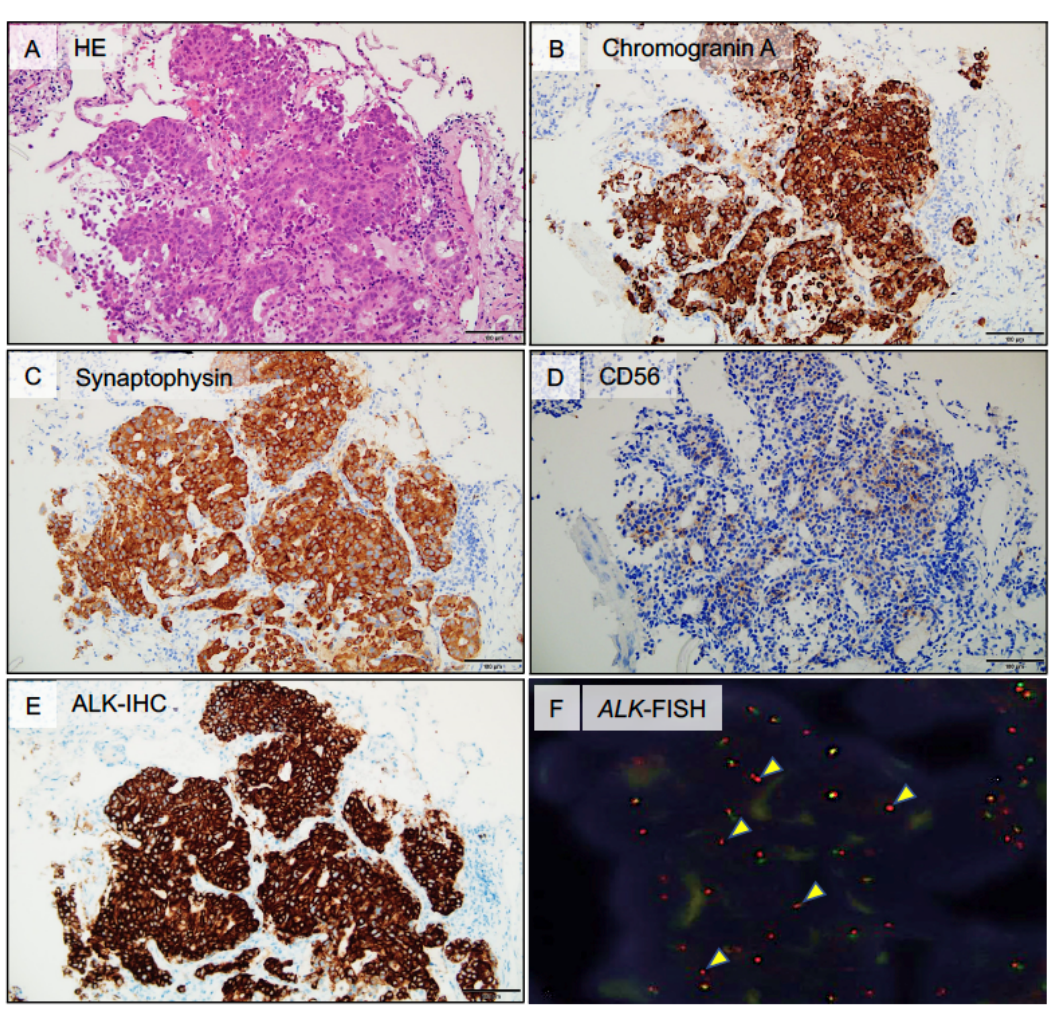
Figure 2. Histopathological findings of the mediastinal LN. ( A ), A hematoxylin and eosin–stained section from the liver tumor showing cells organized in solid nests or forming trabeculae with foci of necrosis and rosette-like structures. ( B ), Immunohistochemical analysis of the liver tumor showing strong diffuse chromogranin A positivity. ( C ), Immunohistochemical analysis of the liver tumor showing strong diffuse synaptophysin positivity. ( D ), Immunohistochemical analysis of the liver tumor showing CD56 positivity. ( E ), Immunohistochemical analysis showing strong diffuse ALK positivity (rabbit monoclonal antibody; D5F3). ( F ), Fluorescence in situ hybridization (FISH) analysis of the ALK locus using a break-apart probe strategy. The upstream and downstream of ALK gene were labeled red and green, respectively. Approximately 58% of tumor cells showed rearrangement at the ALK locus, as demonstrated by split red/green signals. Arrowheads indicate split pattern signals. ALK, anaplastic lymphoma kinase. Scale bars, 100 µm, are shown in panels. Treatment with ALK-tyrosine kinase inhibitor (TKI), alectinib (600 mg/day) was administered.